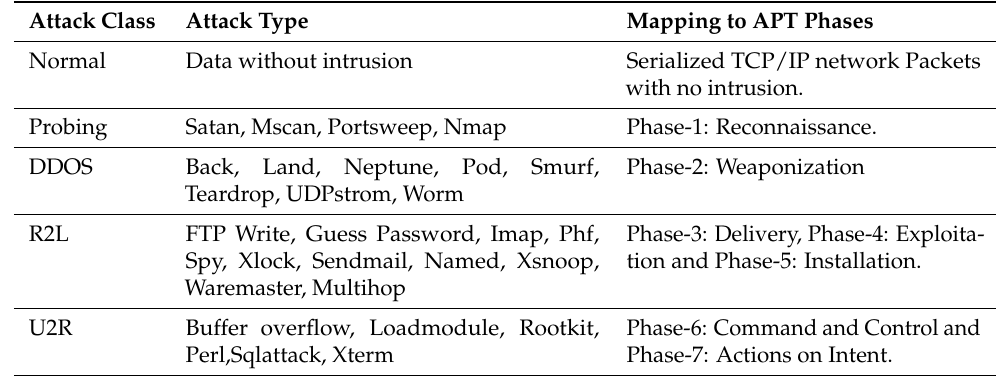
Figure 5. Block diagram of the proposed system. Table 2. Attack classes and